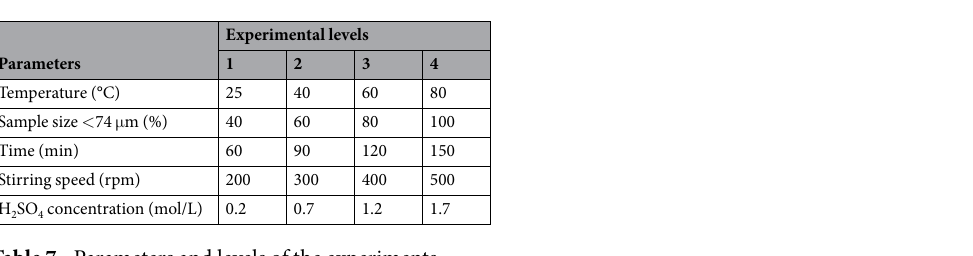
Table 7. Parameters and levels of the